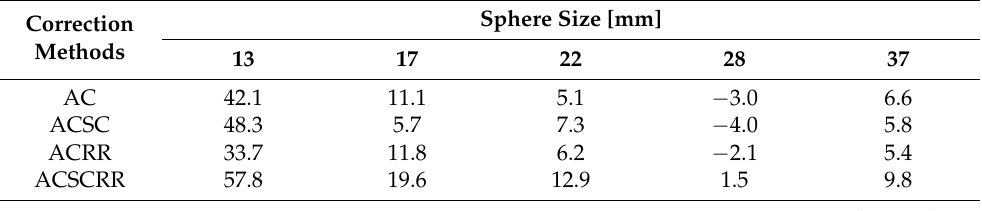
Table 2. Increased rate of the CNR for the SSC mode compared with the SS mode.